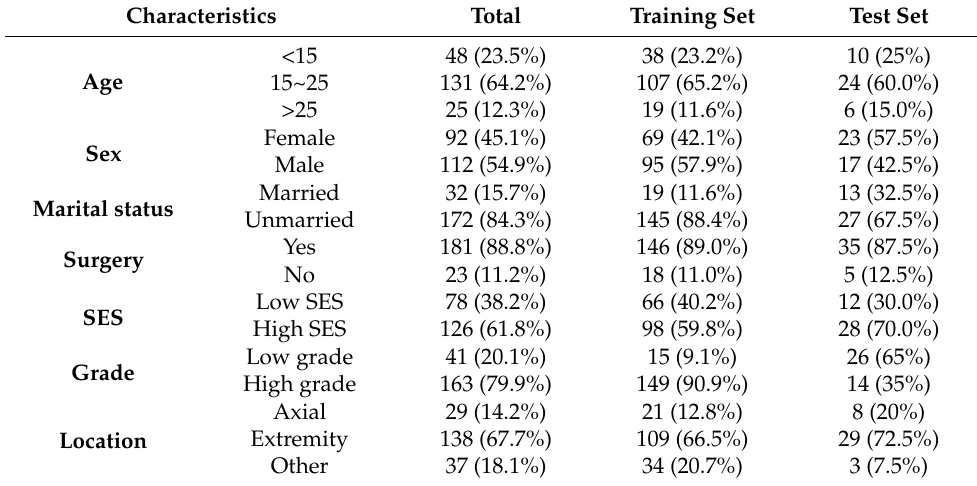
Table 2. Baseline patient